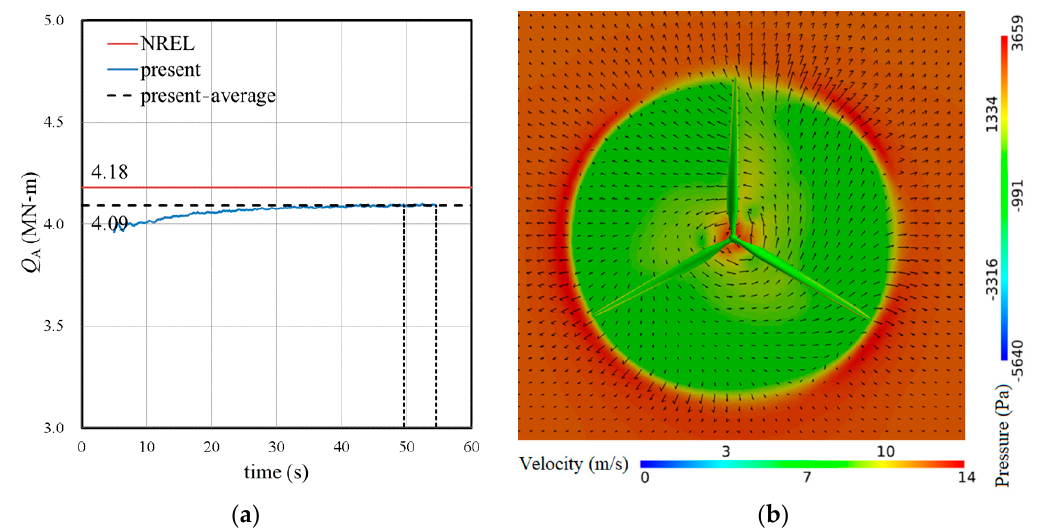
Figure 14. ( a ) Rotor torque at rated condition; ( b ) axial velocity contour and in-plane vector on the midplane between the rotor plane and the tower, and pressure contour on the blade surface for the blade configuration of 0°–120°–240°.